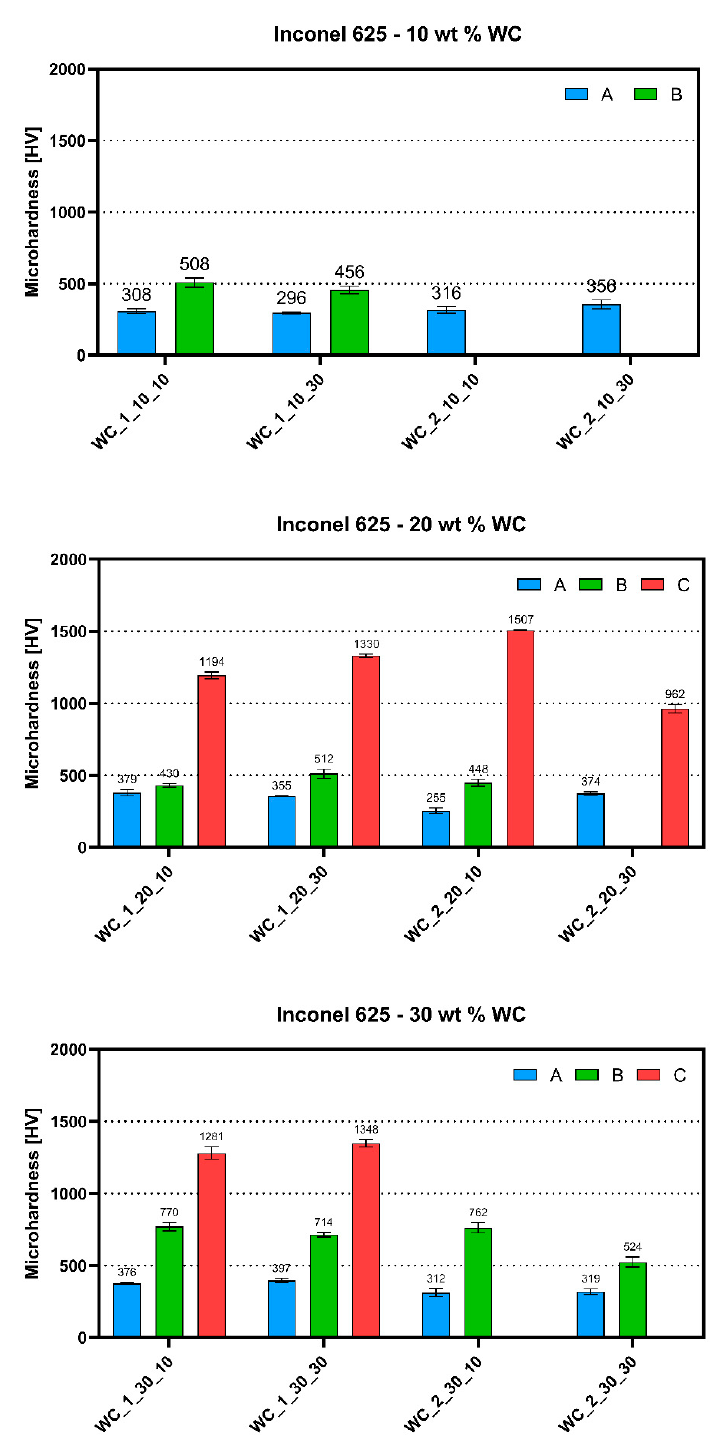
Figure 9. Average microhardness of different phases in DTA-obtained Inconel 625–WC samples measured under a load of 200 g for 15 s where A represents the matrix, B represents the eutectic structure, and C represents carbides.